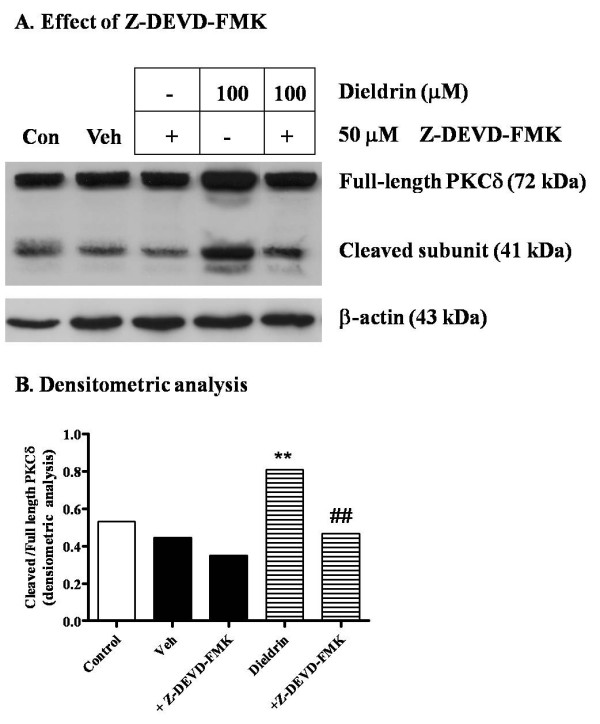
Effect of caspase-3 inhibitor on dieldrin induced PKCδ proteolytic cleavage. In A, N27 cells were pretreated with caspase-3 specific inhibitor, Z-DEVD-FMK (50 μM), for 30 min, and then exposed to 100 μM dieldrin for another 3 hr and cytosolic proteins were collected as described in "Materials and Methods." PKCδ was detected by Western blot, and equal protein loading was confirmed by reprobing with β-actin (43 kDa). Veh represents 0.2% DMSO. In B, Densitometric data of cleaved (41 kDa) and full-length (72 kDa) PKCδ bands in A. Densitometric analysis was performed to determine the level of inhibition of proteolytic cleavage of PKCδ by caspase-3 inhibitor. Density of each band was normalized to 43 kDa β-actin band prior to analysis. The data are expressed as a ratio of cleaved versus full-length. **p < 0.01 compared with vehicle-treated group and ##p < 0.01 compared with dieldrin-treated group.